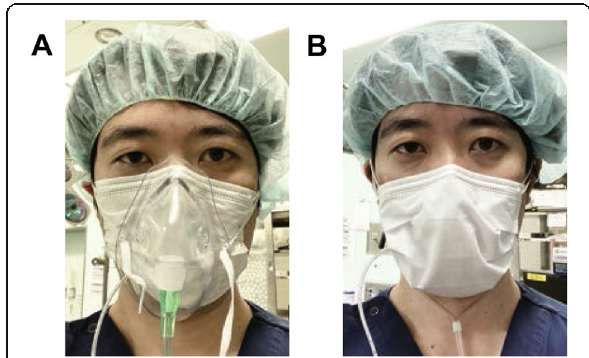
Fig. 1 The two different oxygen administration methods tested.